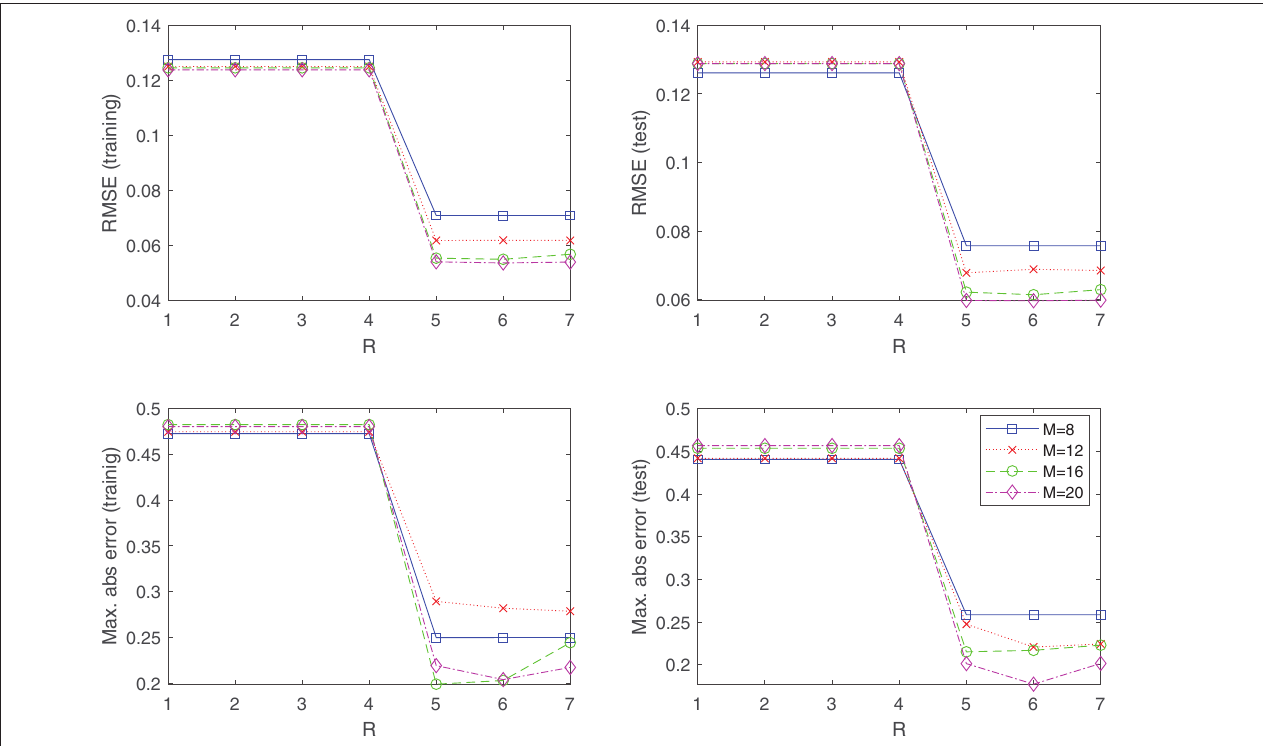
5 separable function, where we see a sudden drop in the training and =